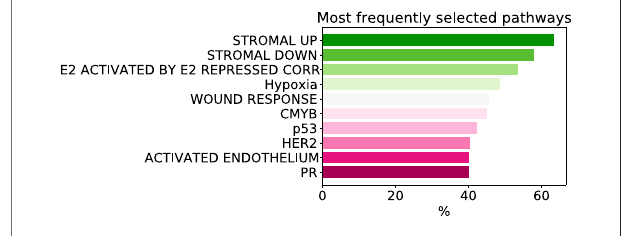
FIGURE 3 | The most commonly selected pathways by group lasso across 16 cancer types with more that 300 samples. The frequency is computed over all random tests, totalling 1,600 data